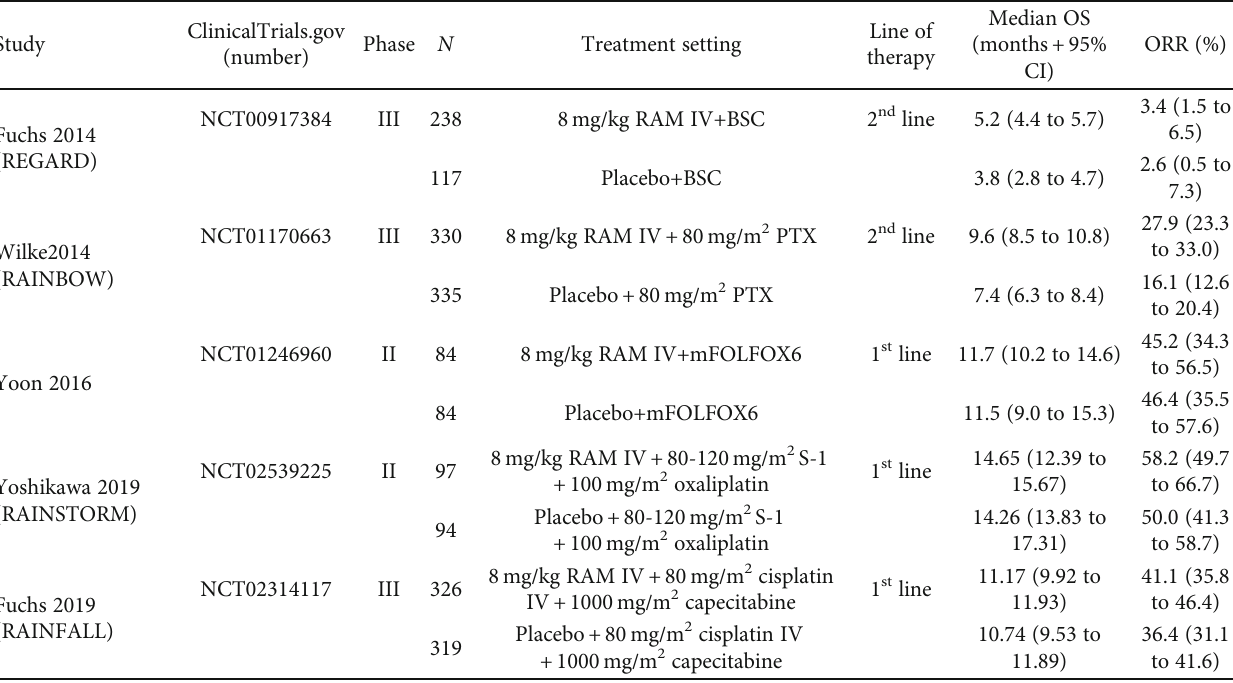
Table 1: Basic characteristics of the included studies.